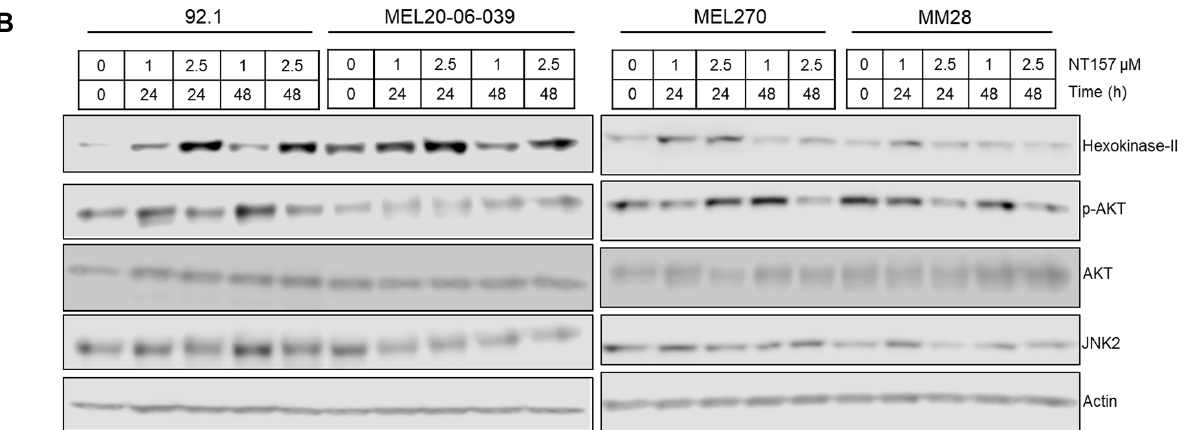
Figure 3. Significant changes in cell signaling proteins detected post-NT157 treatment. ( A ) RPPA protein profiling of four UM cell lines (MEL270, MM28, MEL-20-06-039, and 92.1; represented by each dot). The RPPA expression values are displayed on the y-axis for antibodies that show a significant difference ( p < 0.05) compared to the control sample. Cells were treated either for 24 or 48 h with a 1 or 2.5 µ M concentration of NT157. Green dots represent untreated cells; orange and red dots represent cells treated with 1 and 2.5 µ M of NT157, respectively for 24 and 48 h. ( B ) Western blot analyses to validate some of the significant changes observed in RPPA using antibodies against hexokinase-II, phospho-AKT, total AKT, and JNK2 show treatment and time-dependent (1 and 2.5 µ M for 24 and 48 h) upregulation of hexokinase-II and downregulation of phospho-AKT.